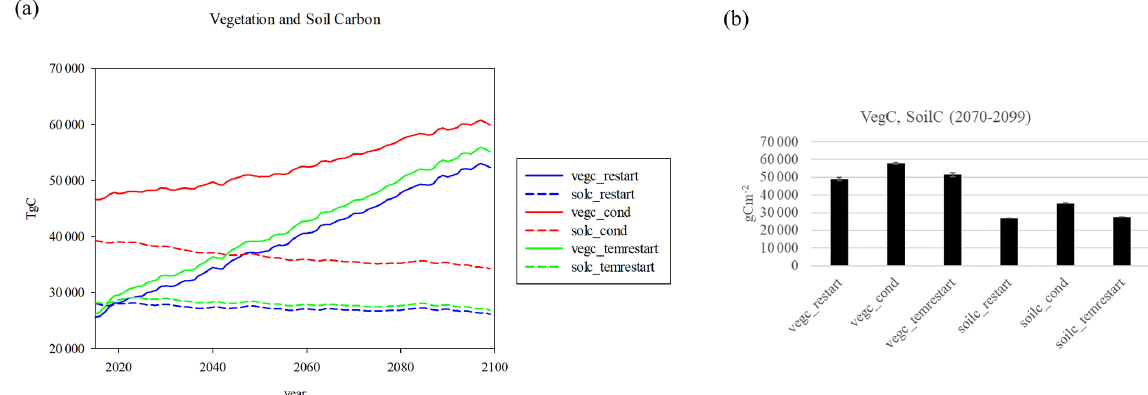
Figure 6. (a) Vegetation and soil carbon in the RESTART, CONDENSED, and TEMRESTART experiments, (b) mean differences 2070–2099 (all three vegetation carbons and soil carbons differ significantly from each other).